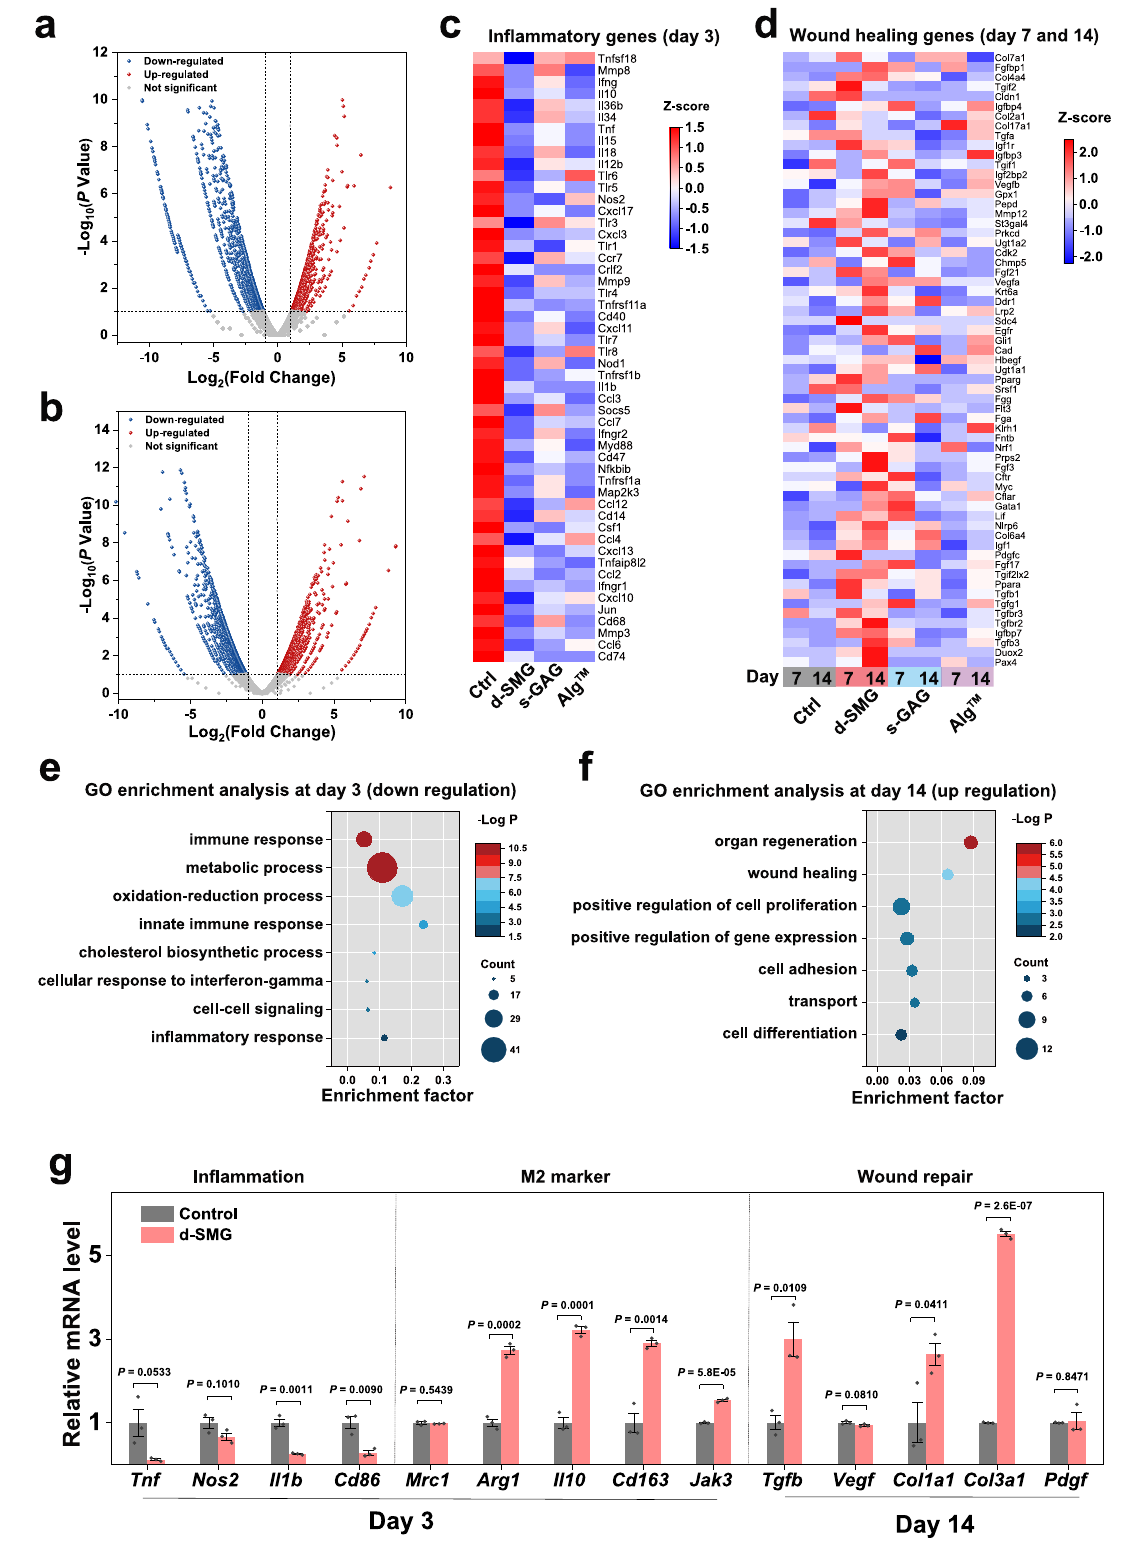
Fig. 8 | Analysis of differentially expressed genes in diabetic wound tissue. a , b Volcano plots showing the upregulated and downregulated genes in d-SMG grouponday3( a )and14( b ). c , d Heatmapofin fl ammationgenesonday3(c)and woundhealinggenesonday7and14( d ). e Geneontology(GO)enrichmentanalysis of the downregulated genes onday 3. f GO enrichment analysis ofthe upregulated